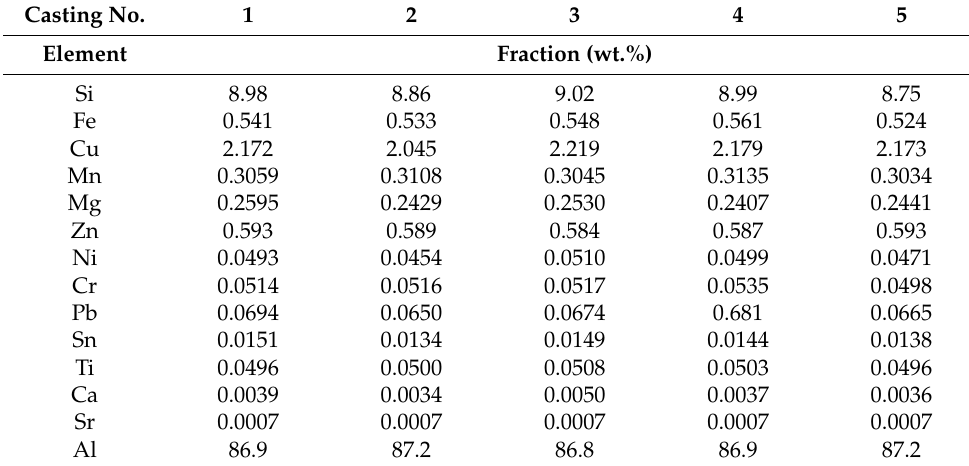
Table 1. The chemical composition of samples for castings Nos. 1 to 5. Casting No.